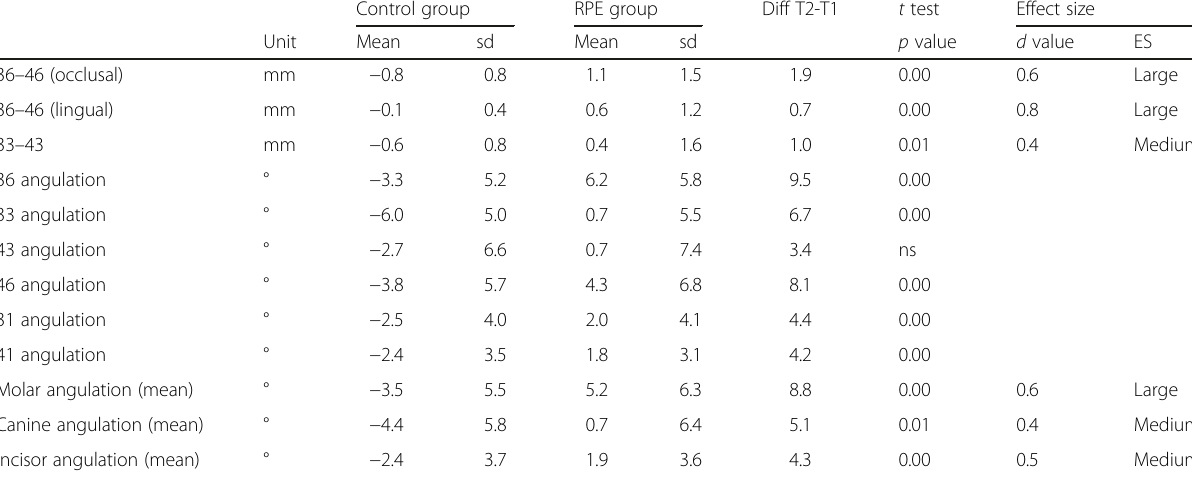
Table 2 Mean and standard deviation (sd) of the differences between T2 and T1 values for each patient Control group